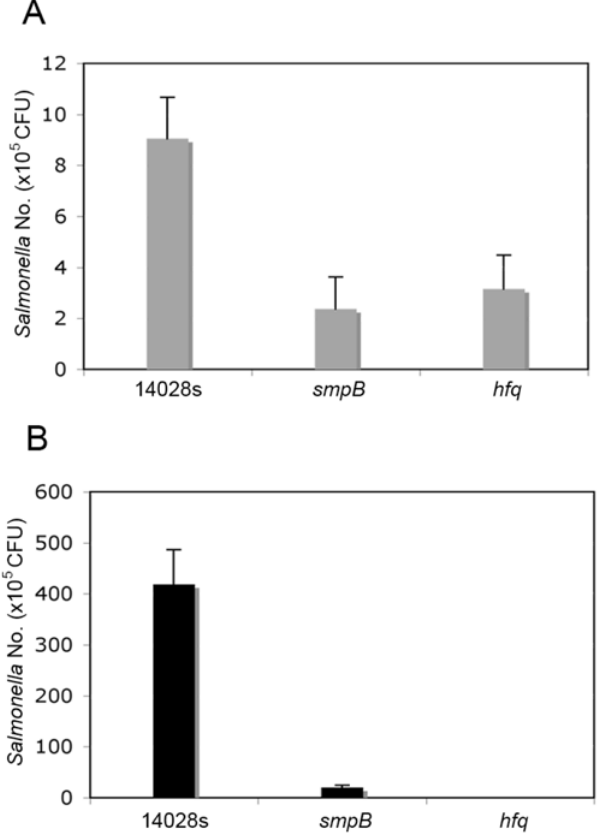
Figure 2. Comparison of survival within macrophage cells. RAW264.7 cells were infected with Salmonella cells grown overnight in LB via MOI of 50. After infection initiation by centrifuging the bacteria onto the cell monolayers at 1,000 6 g for 5 min, cells were incubated at 37 u C with 5% CO 2 for 30 min, treated with gentamicin (100 m g/ml) for 1 h, and incubated in DMEM with gentamicin (20 m g/ml) for the remainder of the test. Macrophage cells were lysed using 1% Triton-X at 1.5 h (A) and 18 h (B) post-infection and the intracellular bacteria were enumerated by serial dilution of cell lysates. The data shown represents the mean and standard deviation of three individual